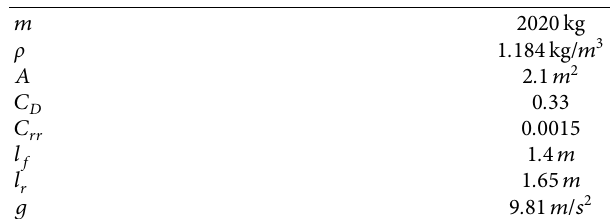
Table 1: Te vehicle